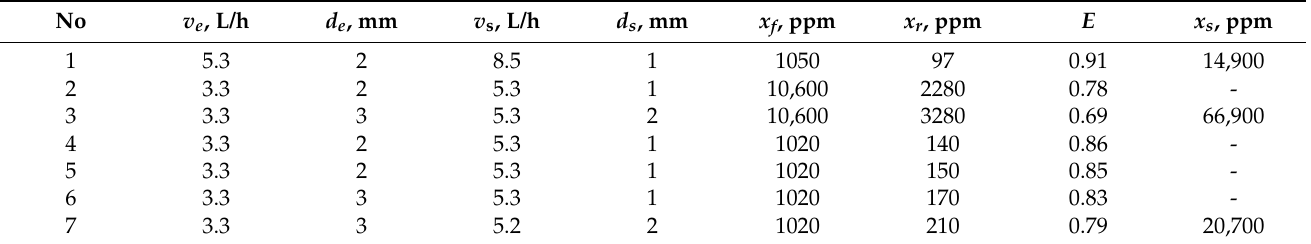
Table 2. Conditions and results of experiments conducted in the small apparatus.